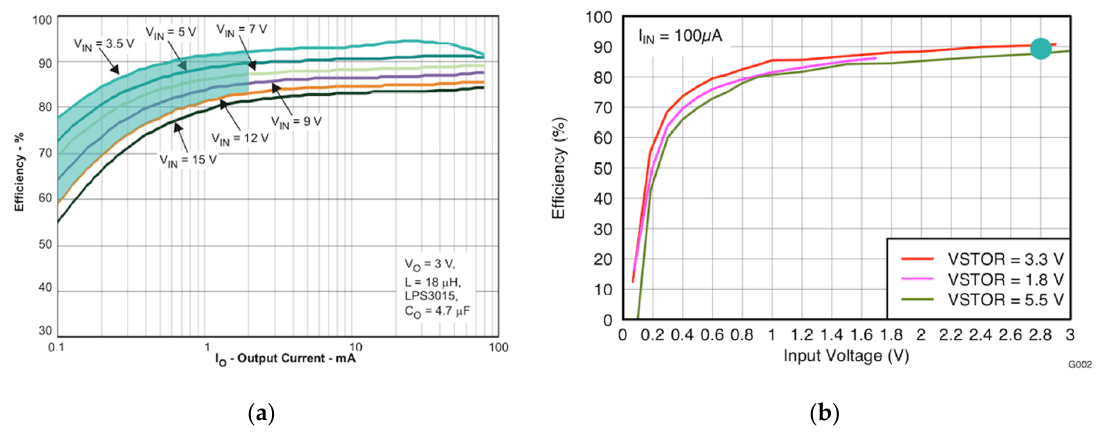
Figure 6. ( a ) Buck converter efficiency curve [40]; ( b ) boost converter efficiency curve [39].